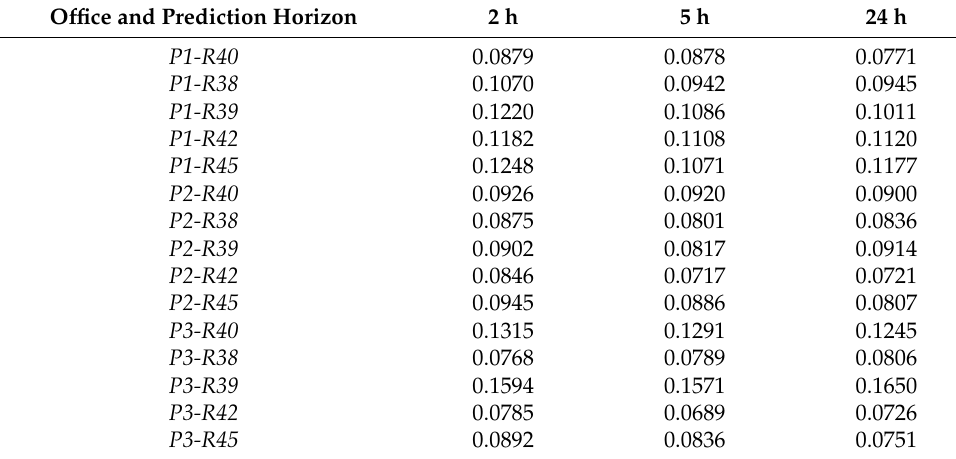
Figure 15. Average RMSE concerning approach calculated for the validation set on 2 h prediction horizon. The single-office predicted temperatures using chosen models for each time horizon are summarised in the table below (Table 4). Table 4. RMSE for each office and time horizon using a generalised